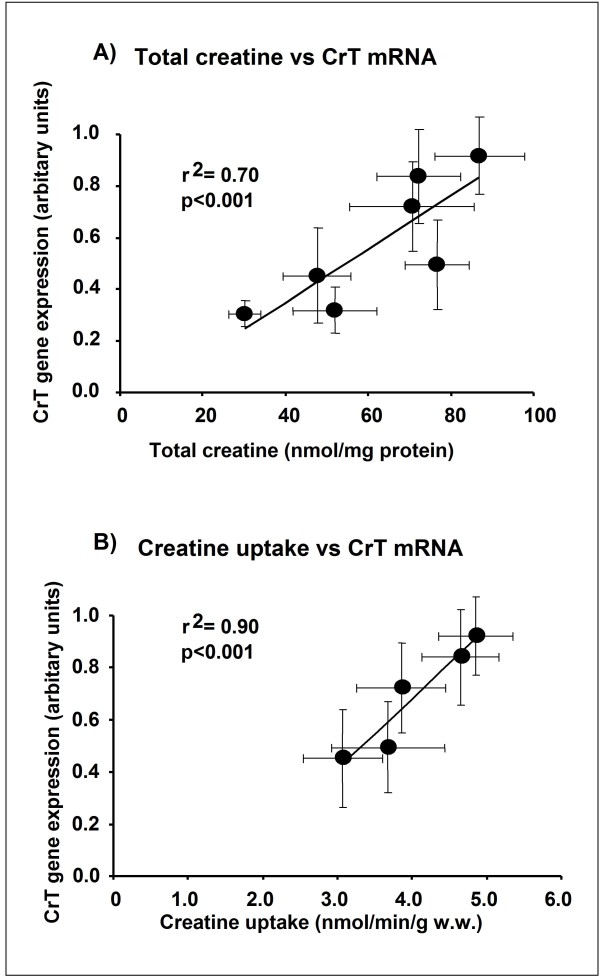
Relationship between CrT mRNA and total creatine (A) and between CrT mRNA and creatine uptake (B), indicated by Pearson's correlation coefficient. Each data point (mean ± S.E.) represents a different developmental age from -2, 7, 13, 21, 33, 50 and 80 days post-partum. CrT mRNA and total creatine data were collected from the same hearts, whereas creatine uptake data was collected from different hearts. There are no data points in (B) for days -2 and 7 since it was not possible to measure creatine uptake in these very small hearts.